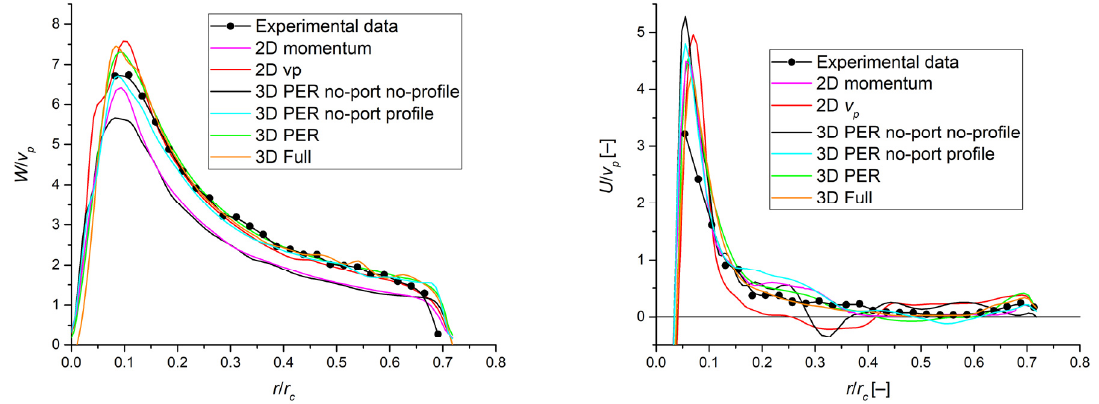
Figure 9. Mean swirl velocity profiles ( left ), axial velocity profiles ( right ). Z = 11 mm, Re = 2000.